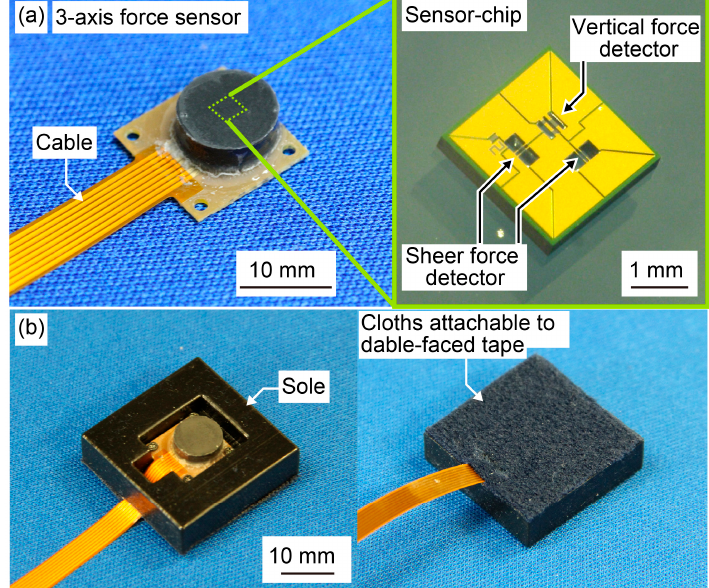
Figure 1. ( a ) Sensor chip and three-axis force sensor; ( b ) Top and bottom of the three-axis force sensor embedded in rubber material used as a